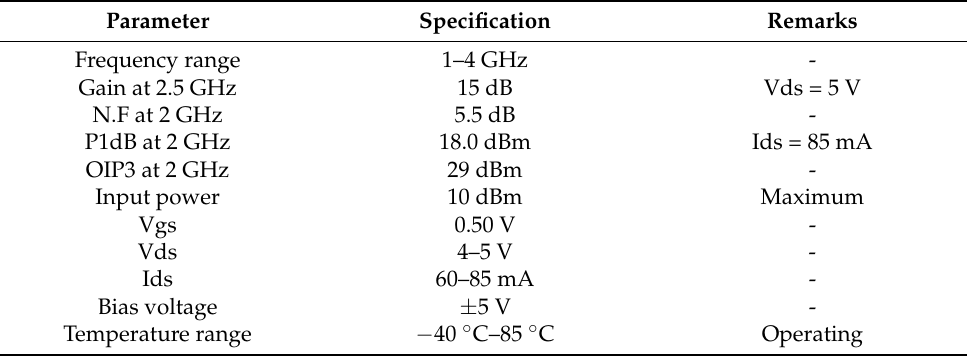
Table 7. Specification of the High-power S band surface mount amplifier